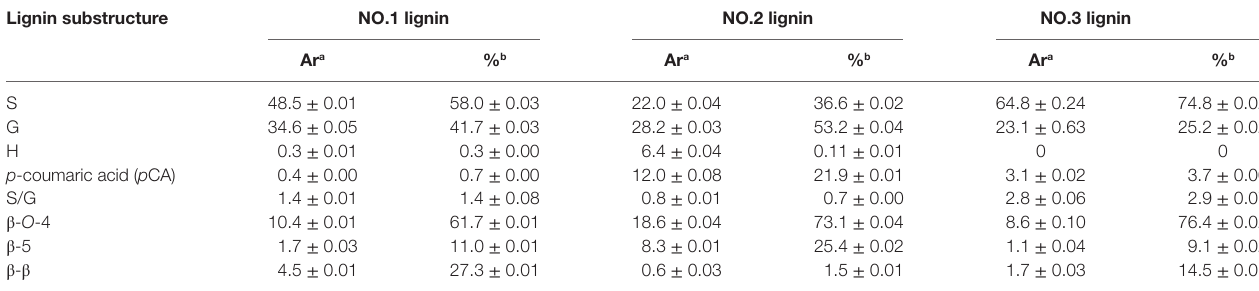
Table 4 | Nuclear magnetic resonance analysis results of three lignin samples fractionated from dilute acid pretreated switchgrass. lignin substructure